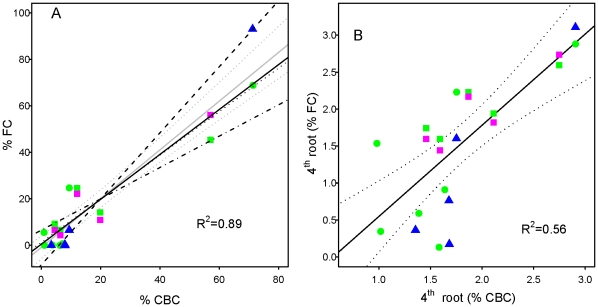
The Mass-Ratio relationship in multiple marine communities.
A. Species % Contributions to Community Biomass (% CBC) describe 89% of the variability in their % contributions to different ecosystem processes (% Functional Contribution, FC) across contrasting ecosystems (grey solid line with dashed grey 95% confidence intervals), however this relationship was significantly different for different ecosystems. Solid line = gross community productivity in salt marsh plants, dashed line = community clearance rate in sub tidal sessile invertebrates, dotted line = gross community productivity in macroalgae turfs, dashed dotted line = ammonium uptake in macroalgae turfs). B. Following 4th root transformation to remove the leverage of dominant species, the relationship was independent of the ecosystem or ecosystem process being studied. Solid lines represent significant regression fits with dotted lines representing their 95% confidence intervals. Symbol and colour assignment is the same as Figure 1.